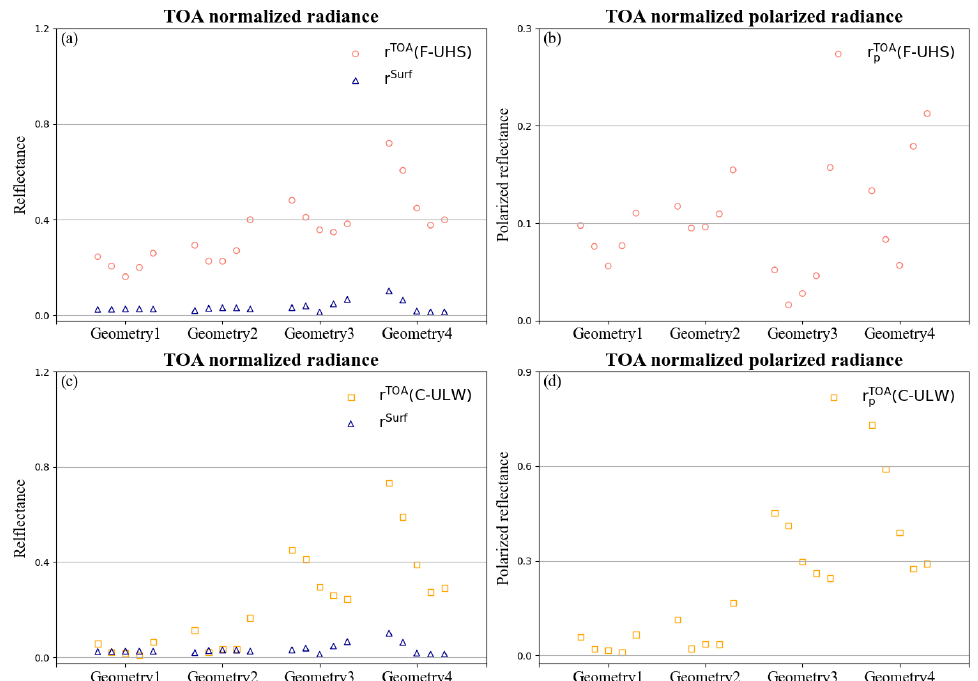
Figure 4. Contributions of TOA reflectance and TOA polarized reflectance at 388 nm with vegetated surface, and AOD = 0.6 at 550 nm. ( a , b ) correspond to the F-UHS aerosol type, while ( c , d ) correspond to the C-ULW aerosol type.